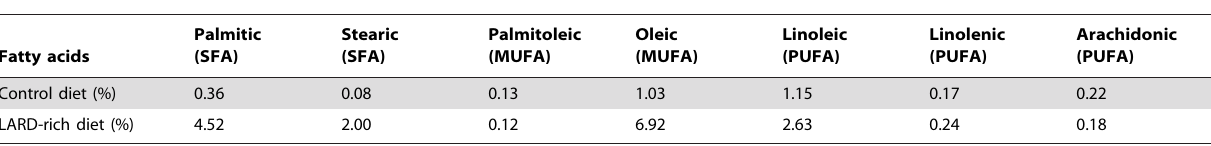
Table 1. Content of fatty acids in experimental diets.